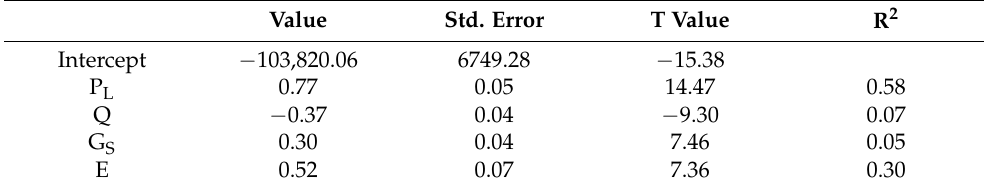
Table 3. Coefficient and standard error of robust regression model, where ∆ V is the dependent variable explained by P L , Q, G S , and E, and relative importance metrics of regressors P L , Q, G S , and E with response variable ∆ V.